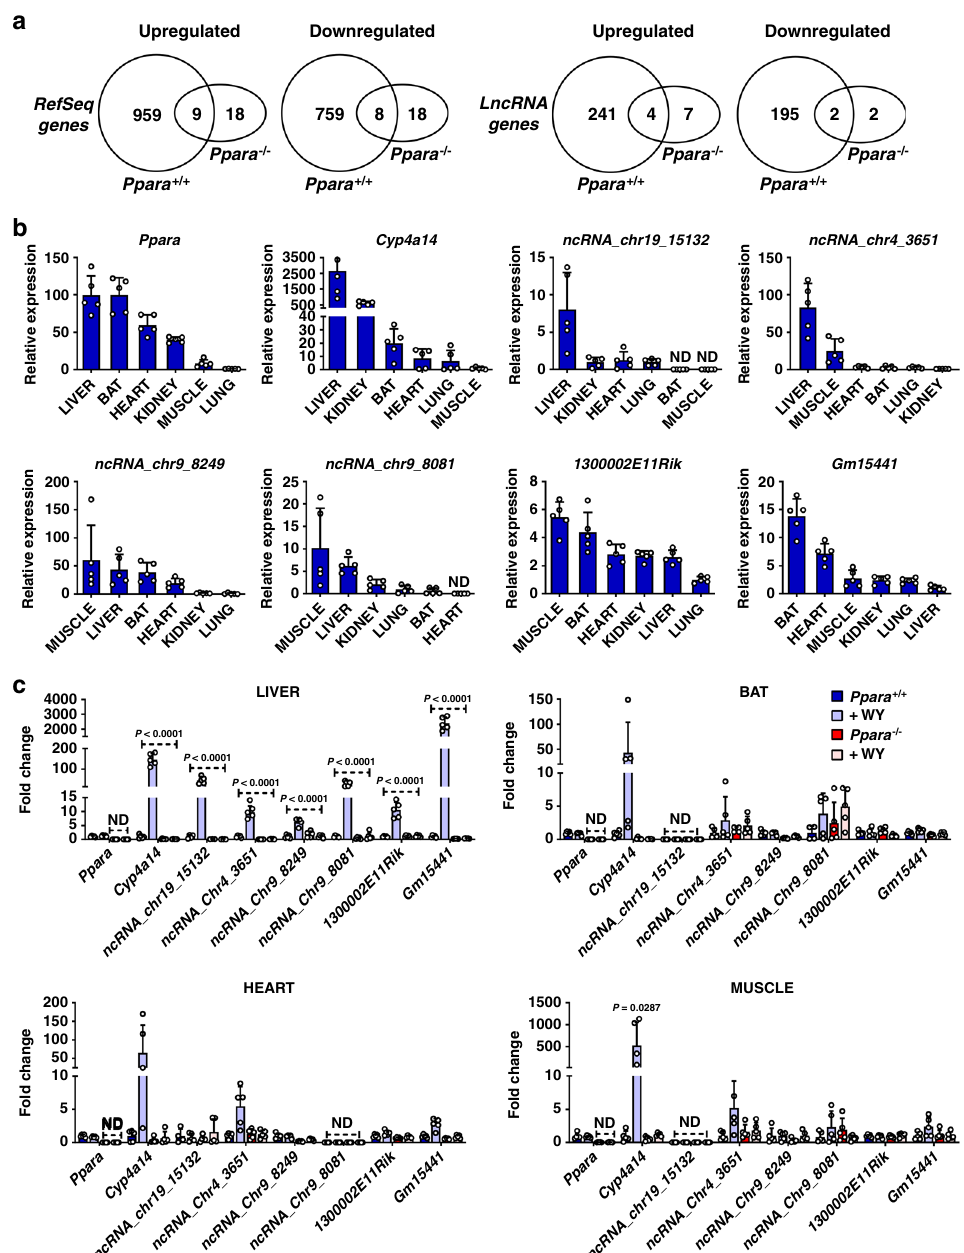
Fig. 1 LncRNA identi fi ed as PPAR α targets are expressed in several oxidative tissues but exhibit liver-speci fi c transcriptional response to WY-14643. a Venn diagrams of RefSeq transcripts and lncRNA transcripts that were differentially regulated by WY-14643 (fold change > 2 at FDR < 0.05) in wild-type and in Ppara − / − mouse liver, as determined by RNA-seq. 123 of the RefSeq genes are non-coding, indicated by their NR accession numbers. Six RefSeq genes and six lncRNA genes show opposite responses to WY-14643 treatment and are excluded from the gene counts shown. b Relative basal lncRNA expression in select tissues. c LncRNA expression in tissues from Ppara + / + and Ppara − / − mice treated with WY-14643 for 48 h. At least fi ve mice were analyzed for each genotype and treatment group. Each bar represents the mean ± SD for n = 5 tissue samples. Adjusted p values, provided in the panels, as determined by ANOVA with Tukey ’ s multiple comparison correction, one-sided for comparisons to Ppara + / + mice or as shown (dashed horizontal lines). ND not Pathway analysis revealed that the WY-14643 upregulated genes are most highly enriched for the following biological processes: lipid metabolism, peroxisome, DNA replication, DNA repair, cell cycle, and fatty acid oxidation (Supplementary Table 1). The downregulated genes are most highly enriched for: secreted factors, monooxygenase, immunity, serine protease inhibitor, metabolism of xenobiotics, and response to virus (Supplementary Table 2). PPAR α -dependent lncRNAs identi fi ed